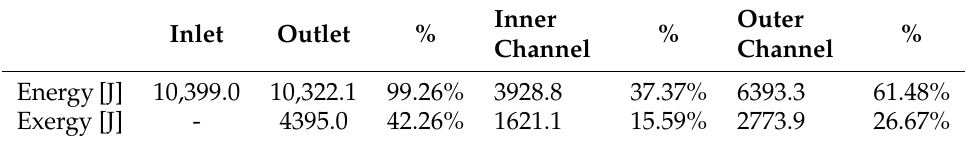
Table 1. Results of energy efficiency analysis. “%” mean percentage of inlet energy.